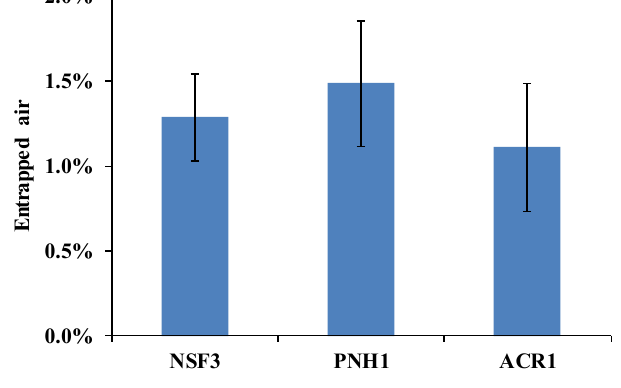
Figure 5. Mean value of entrapped air.